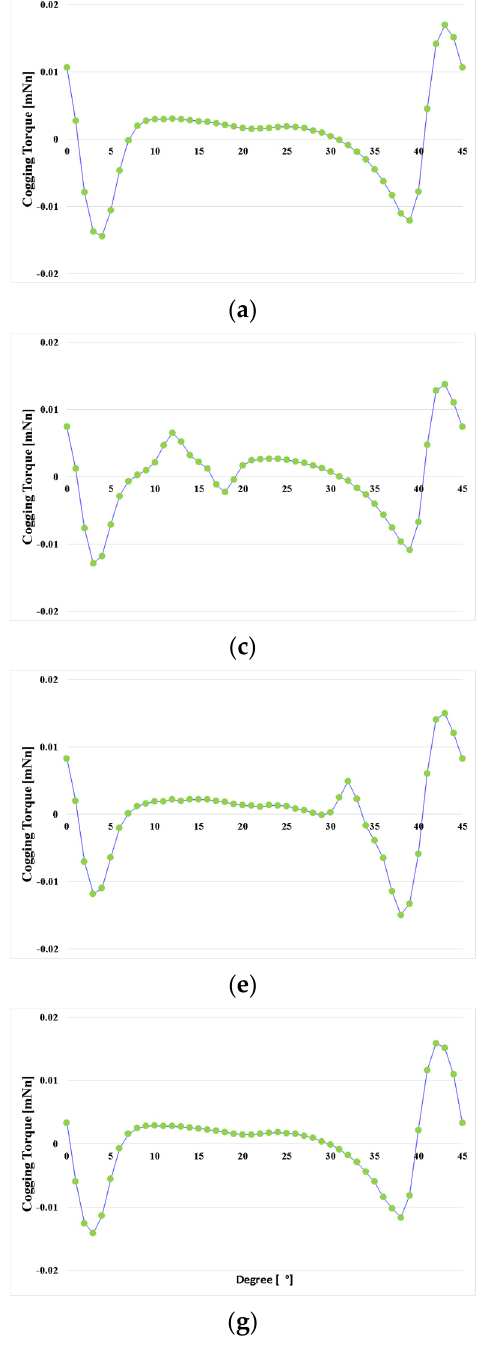
Figure 7. Trend analysis of cogging torque for notch position ( a ) 2°; ( b ) 7°; ( c ) 15°; ( d ) 25°; ( e ) 35°; ( f ) 40°; ( g ) 43°.